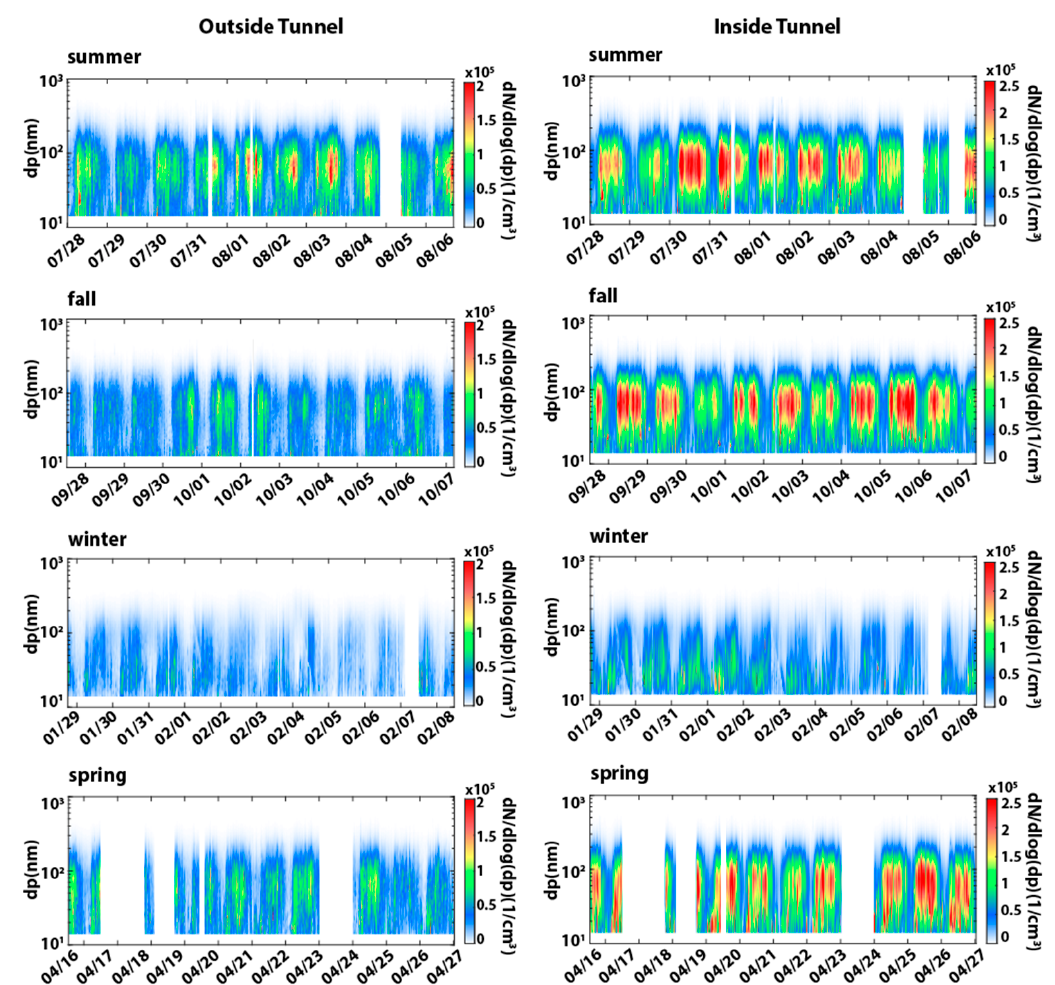
Figure 4. Evolution of seasonal particle size distribution in the inside- and outside of the tunnel estimated by using SMPS.